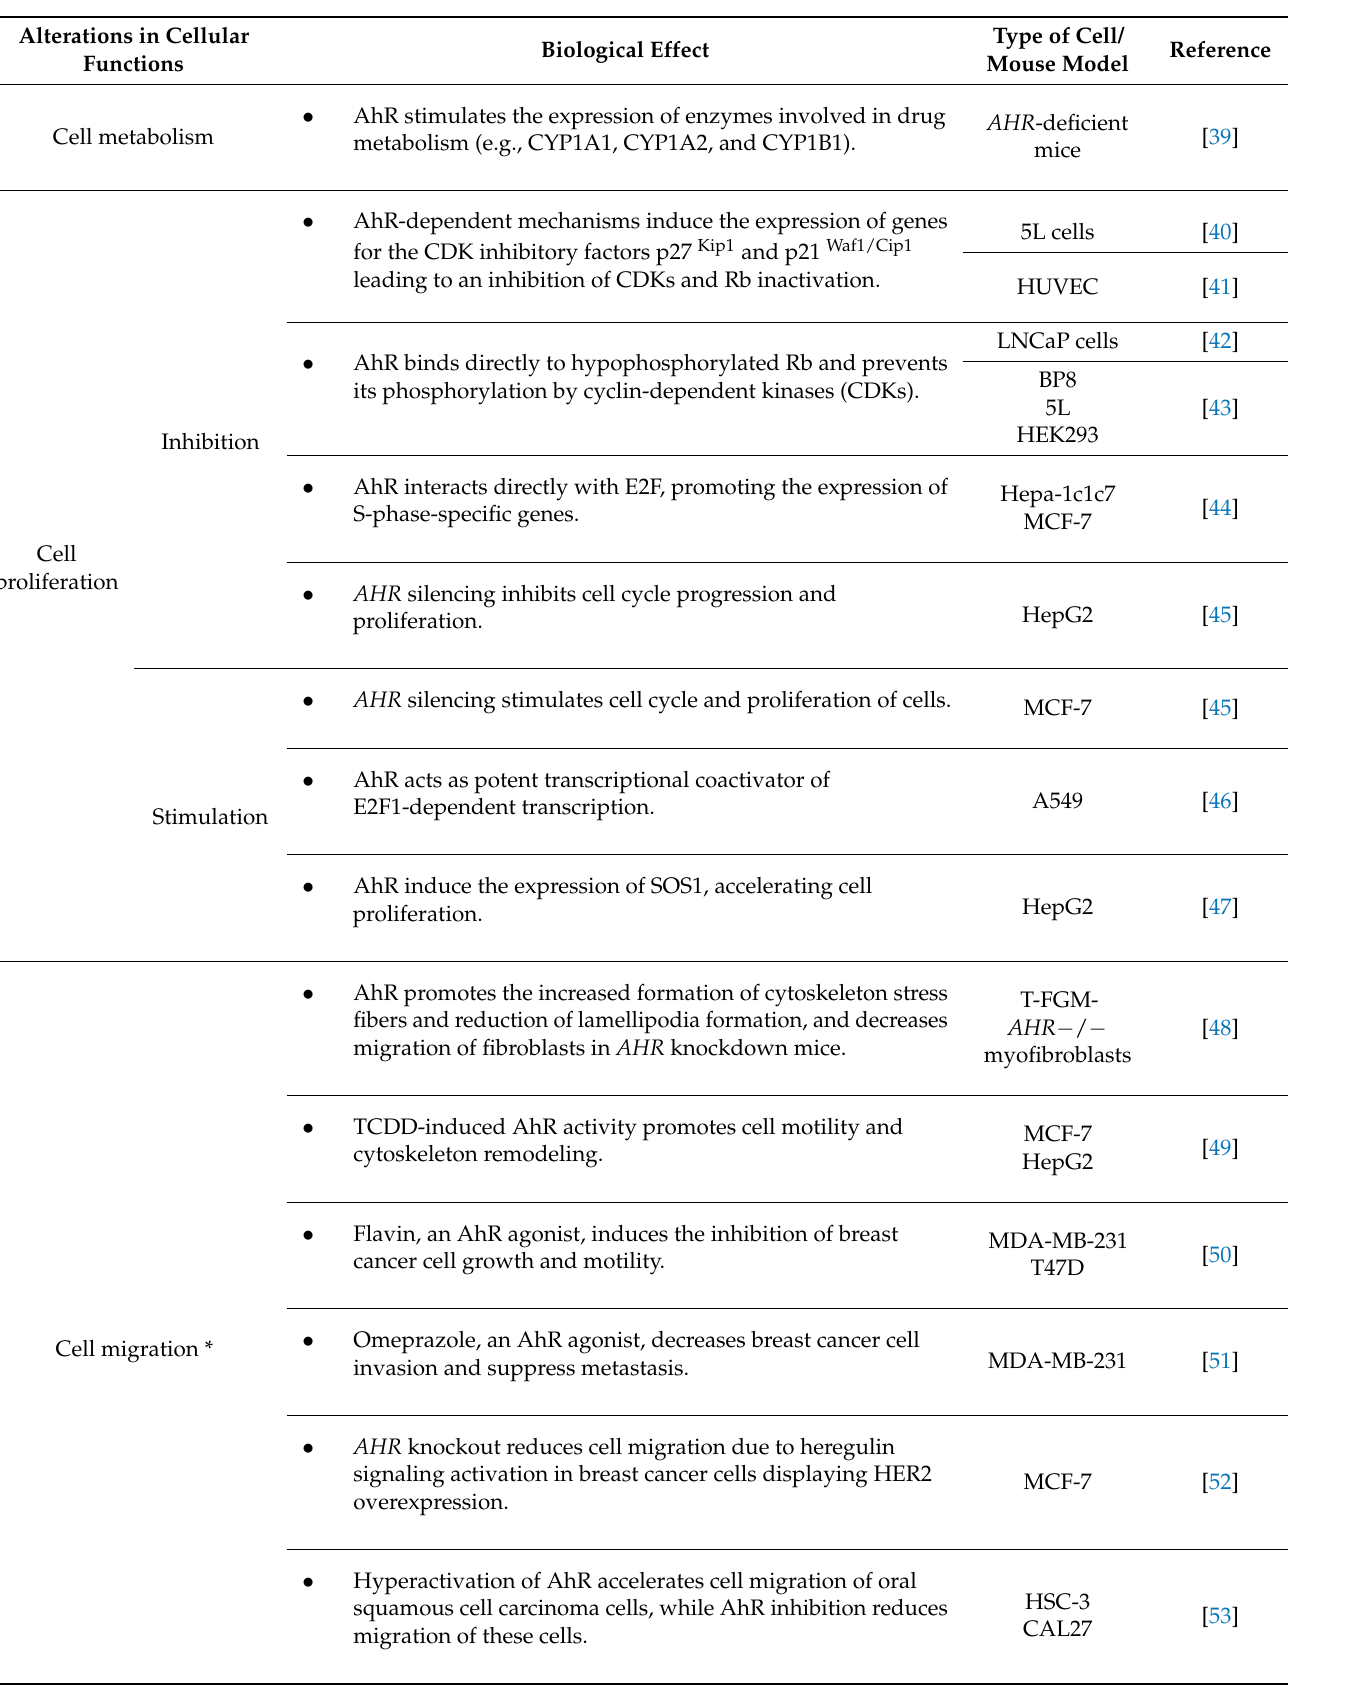
Table 1. The effect of AhR on selected cellular